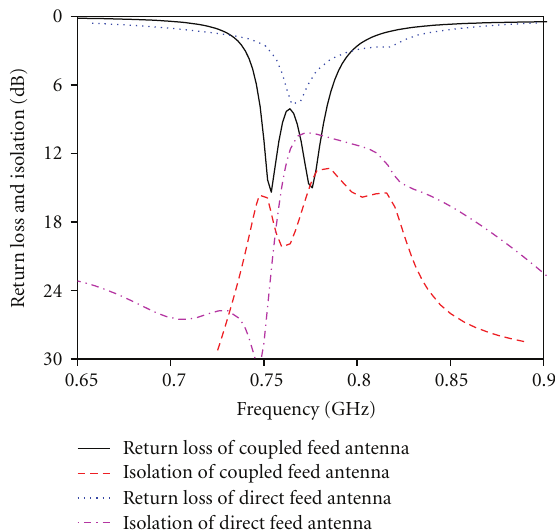
Figure 4: Return loss of the antenna with respect to a variation in the separation width between the radiating element and the coupled feed strip ( 𝑊 3 ).